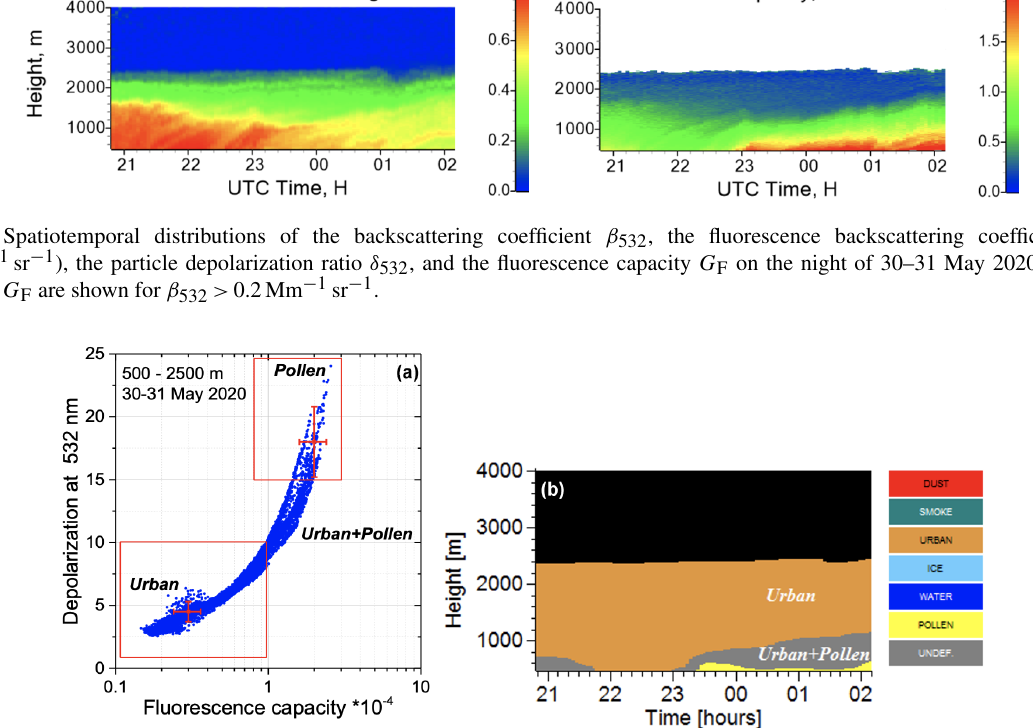
Figure 7. (a) The δ 532 - G F diagram for observations in the 500–2500m height range and (b) spatiotemporal distribution of aerosol types on the night of 30–31 May 2020. The gray coloring shows an undefined aerosol type, which is a mixture of urban and pollen for this case. Measurements with β 532 < 0.2Mm − 1 sr − 1 are marked in